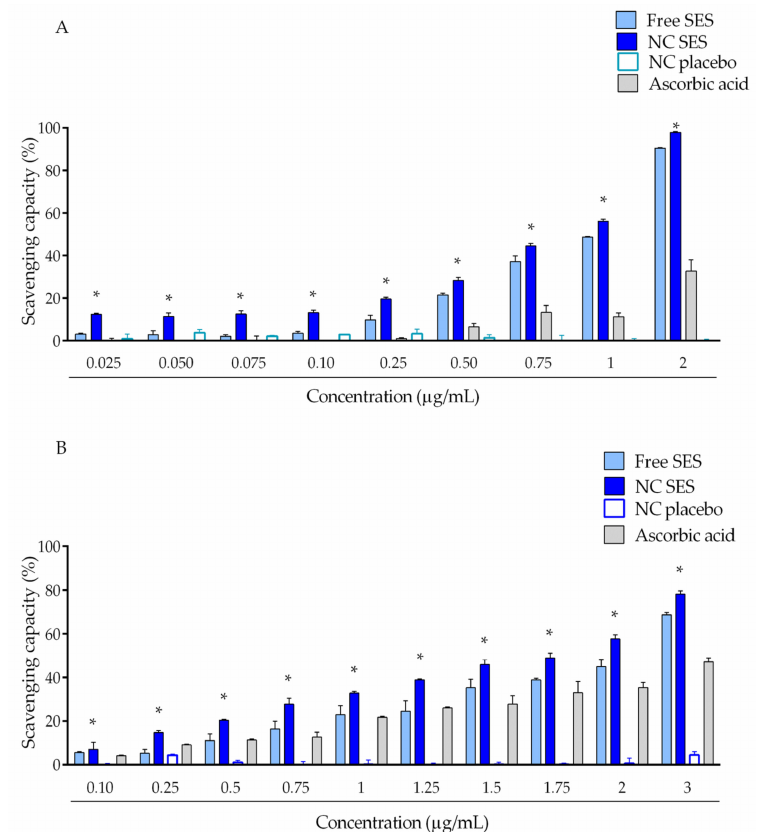
Figure 3. Scavenging of ABTS ( A ) and DPPH ( B ) radicals. The values are reported as the mean ± SD of three independent experiments/group. All data were analyzed by ordinary one-way ANOVA followed by post hoc Tukey’s test at each point (individual concentrations). The asterisks (*) denote the significant difference between the NC SES and Free SES (* p <